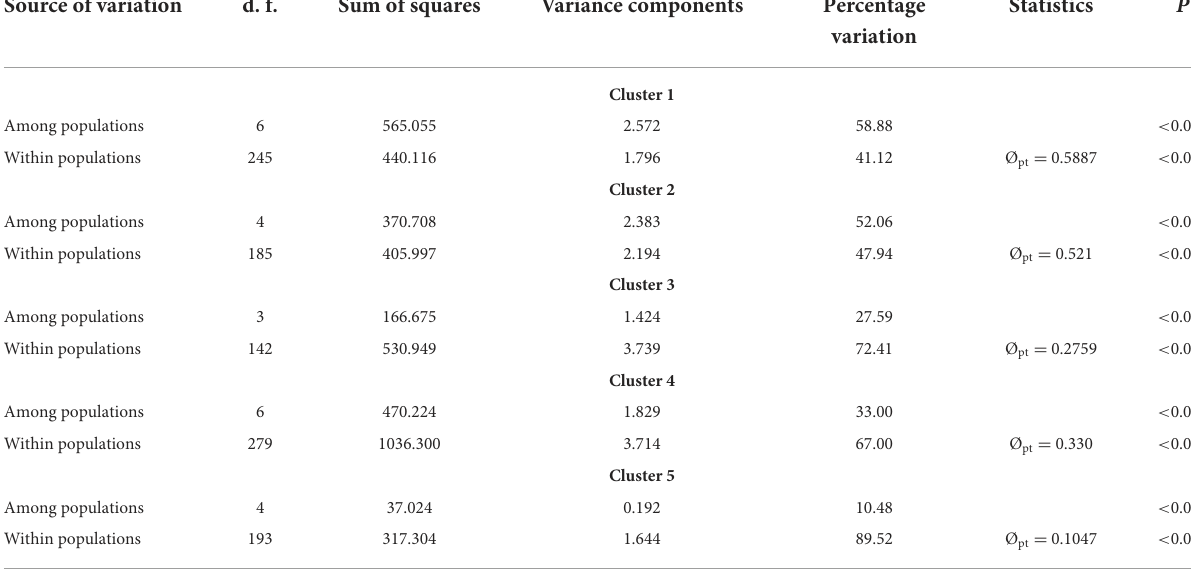
TABLE 4 AMOVA results for each of the inferred clusters based on 23 neutral loci. Source of